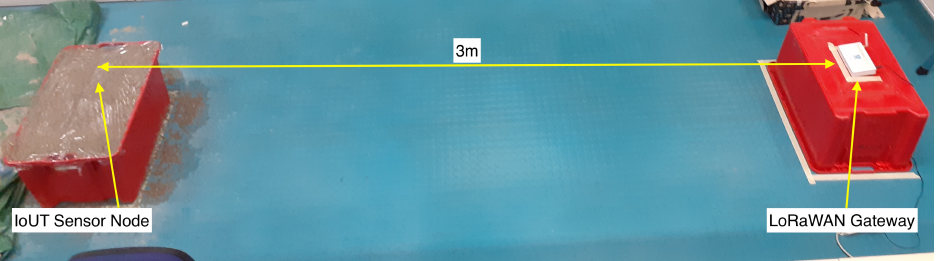
Figure 5. Testing setup: the IoUT sensor node buried in sand within the plastic case and the LoRaWAN